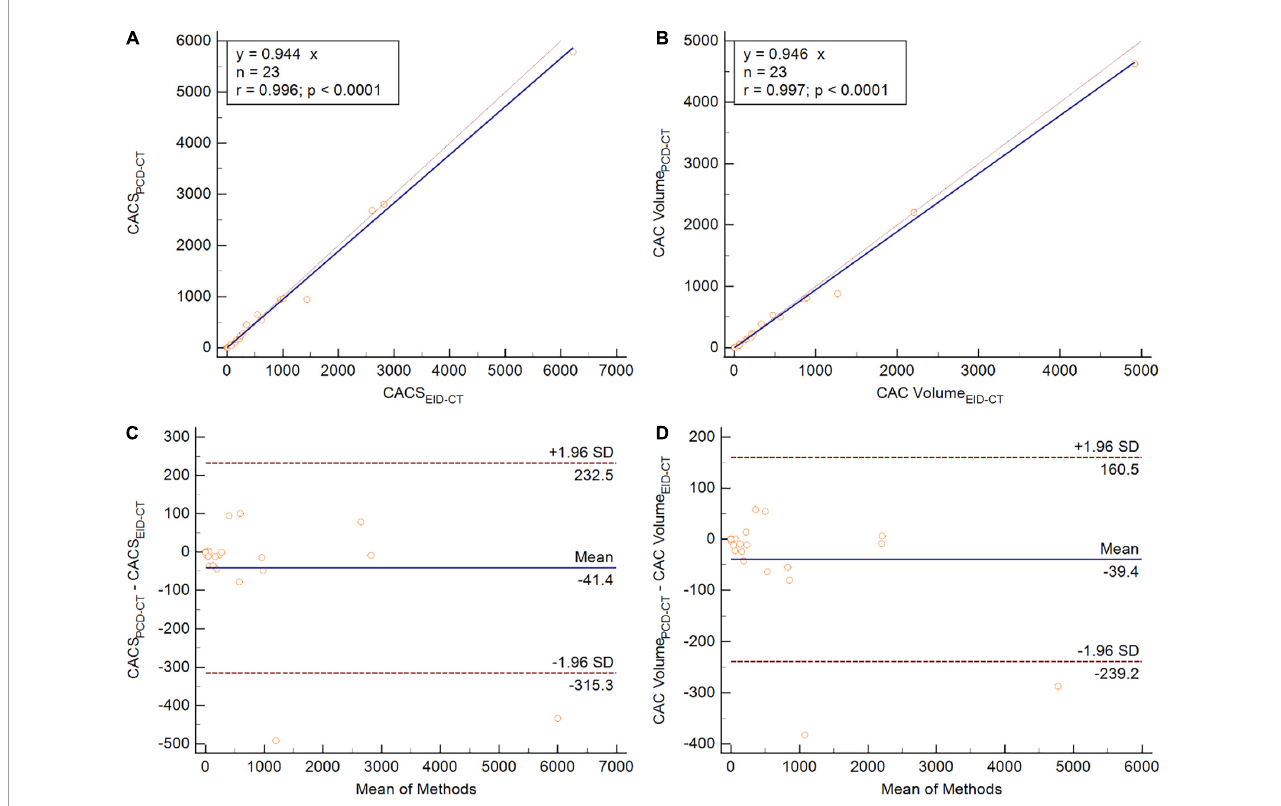
FIGURE5 Patient study comparing CACS (A,C) and CAC volume (B,D) between PCD-CT and EID-CT in scatter- (A,B) and Bland-Altman plots (C,D) . SD, standard deviation; r , Spearmen correlation.